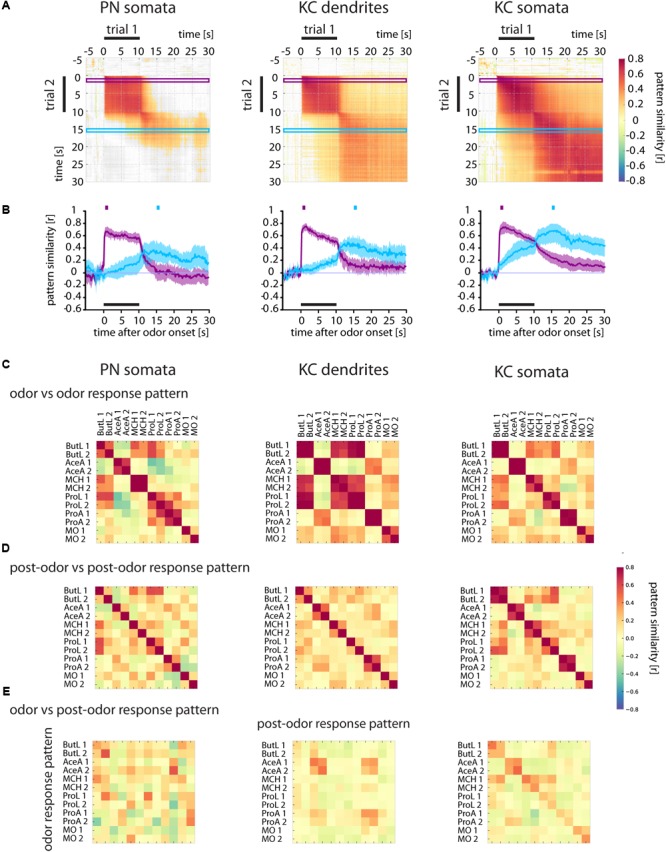
Odor and post-odor responses evolve differently in different brain areas. (A) Correlation analyses of repeated odorant stimulations (trial 1 vs. trial 2) show that odor and post-odor response patterns are reproducible and stable in PN somata, KC dendrites, and KC somata (see high correlation values during the odor and after odor offset). In PN somata, the odor response pattern changes into a distinct post-odor response at odor offset (see the gray areas right and below the correlated odor pattern rectangles). In KC dendrites, and even more in KC somata, the pattern change is smooth and the post-odor response pattern retains a similarity to the odor response pattern. Correlation values were defined as being significant when p < 0.005 and are color coded (color scale bar, right). Non-significant values are shown in gray. Purple and blue frames mark the time windows used to calculate the time-resolved correlation, shown in (B). (B) Time-resolved correlation between the odor response pattern (marked by the purple square above the graph) and the post-odor response pattern (marked by the blue square) of an odor response with all time points of another response to the same odorant (purple and blue traces, respectively). The odor response pattern breaks down at odor offset in PN somata, and yields to a distinct post-odor response pattern which evolves at odor offset. Conversely, KC somata show a smooth transition that retains substantial information about the odorant response also during post-odor activity. Mean ± SD obtained by bootstrap analysis (on animals, 1000 times). See Supplementary Figure S3 for the same data split by odorants. (C) Correlation of the odor response patterns of different odorants and repeated odorant stimulations. Each odorant was given twice (e.g., ButL 1 and ButL 2; see methods for odorant abbreviations). Odor response patterns of repeated odorants are reproducible in all three cell/compartment types (large diagonal squares in the upper row). Some odorants elicited similar response patterns in KC dendrites (off-diagonal dark squares, e.g., ButL 1 and ButL 2 with ProL 1 and ProL 2). (D) Correlation of the post-odor response patterns between different odorants. Post-odor patterns are not reproducible in PN somata (high values along the diagonal form only small squares), but quite reproducible in KC dendrites and KC somata (large squares in the diagonal with high correlation values). (E) Correlation of odor response patterns with post-odor response patterns. In PN somata or KC dendrites, the odor response patterns are not correlated to the post-odor response patterns within the same odorant stimulation (see diagonal entries), but there is a consistent correlation in KC somata (increase in correlation along the diagonal). See Materials and Methods for number of flies and somata/ROIs.